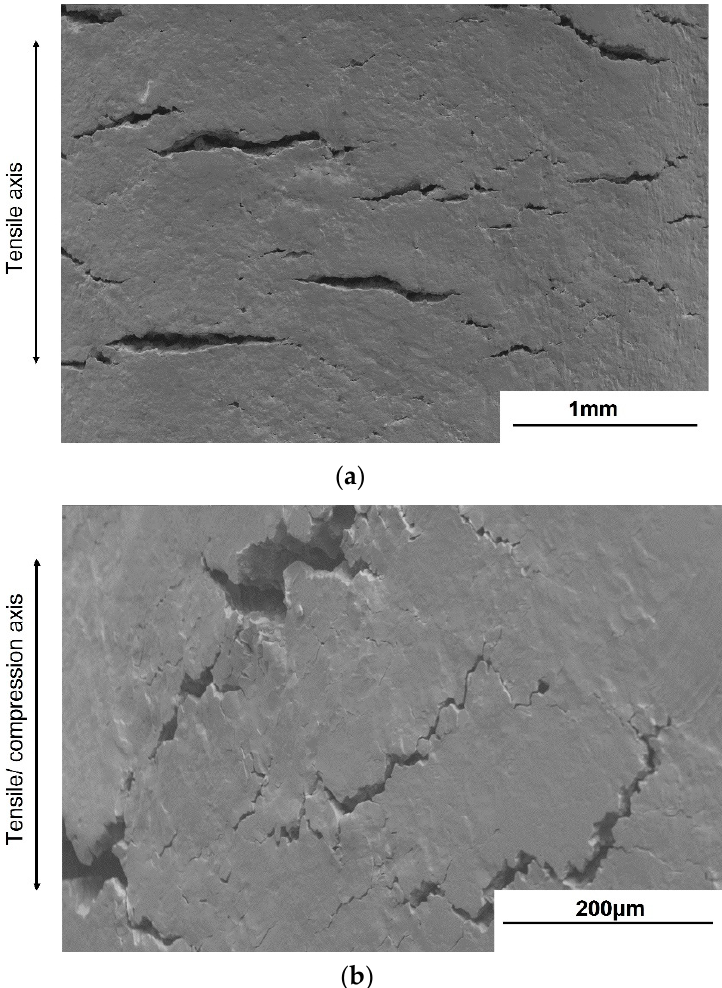
Figure 12. SEM images of the subcracks on the side surface of galvanized steel at ( a ) R = 0.01 and ( b ) R = − 1.0.